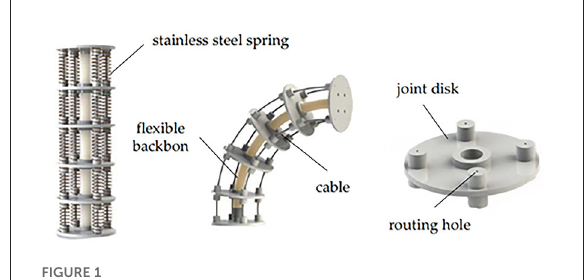
FIGURE1 The structure of the